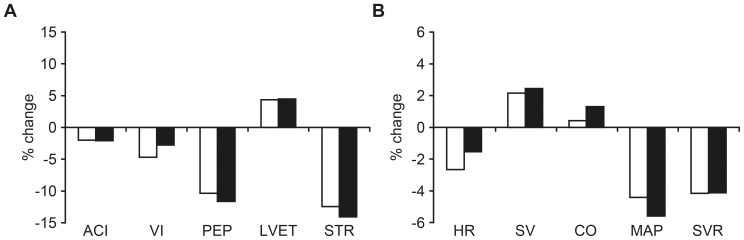
Changes in parameters of cardio-vascular function from baseline to 90 seconds after passive leg raising.A. Systolic function and contractility B. Systemic blood flow and resistance. White bars represent pregnant women and black bars represent non-pregnant women.